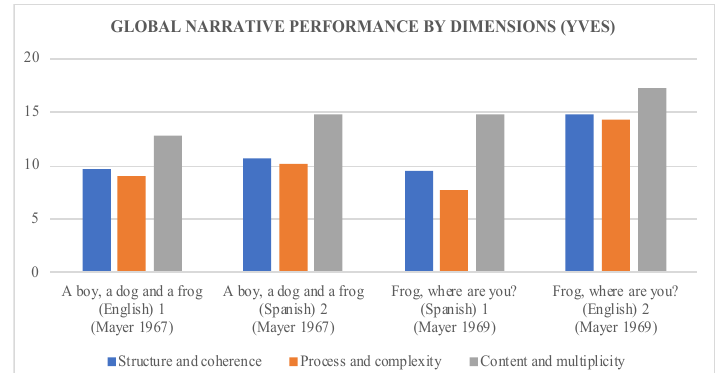
Figure 2. Olivia’s global scores by dimensions. Languages 2018 , 3 , 22